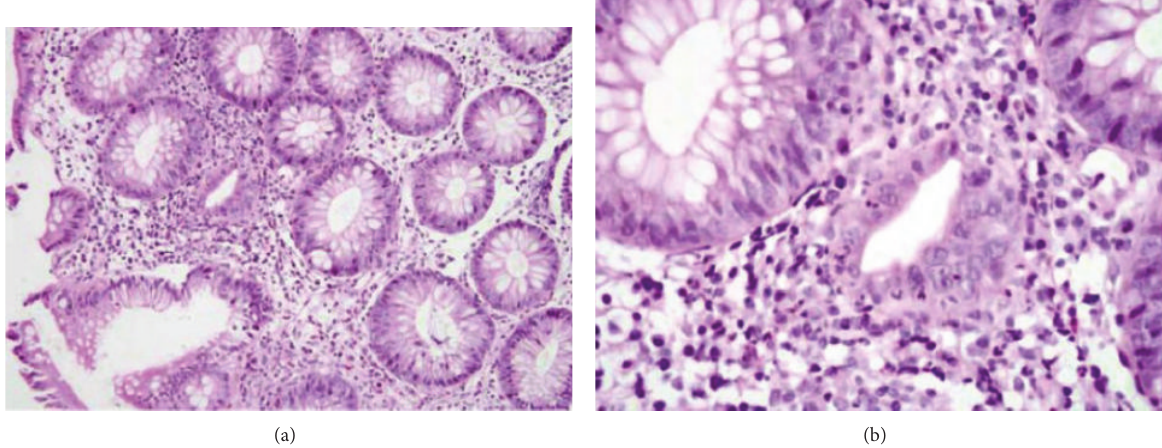
Figure 6: Histopathologic analyses showing focal active colitis (a) with crypt destruction, loss of goblet cells, and neutrophilic infiltrates in the crypt epithelium (b) [13]; reproduced with permission from Maker et al. 2005